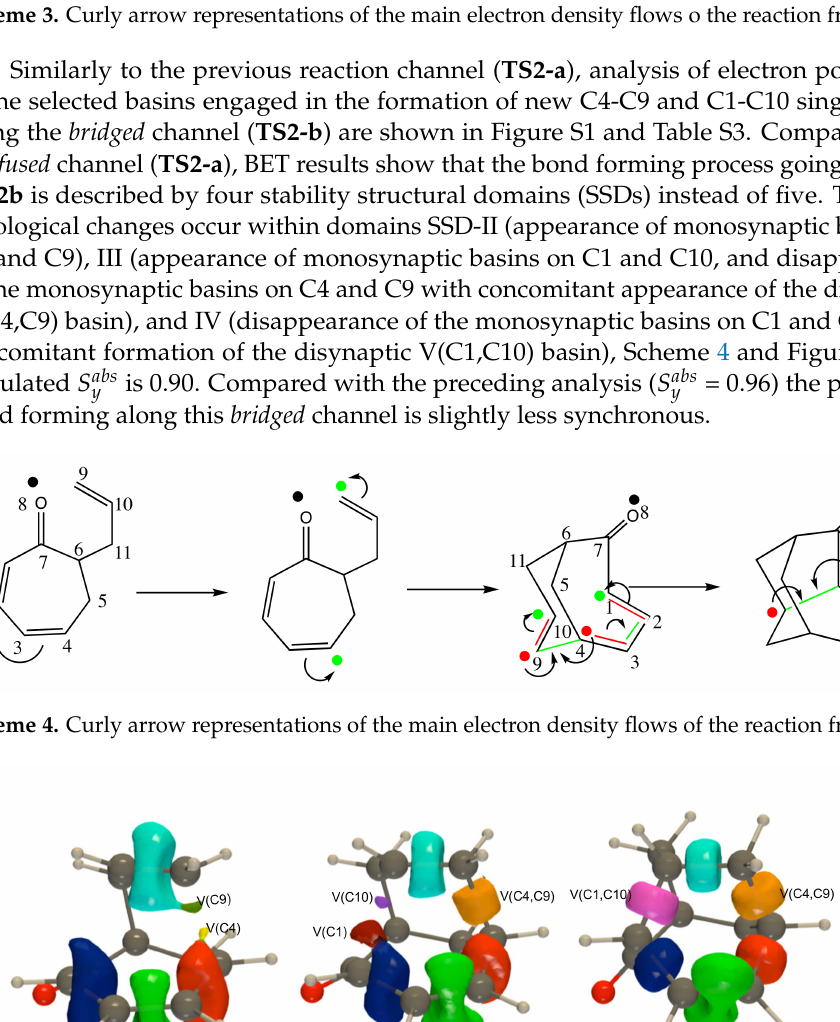
Scheme 3. Curly arrow representations of the main electron density flows o the reaction from 2 to 3 .